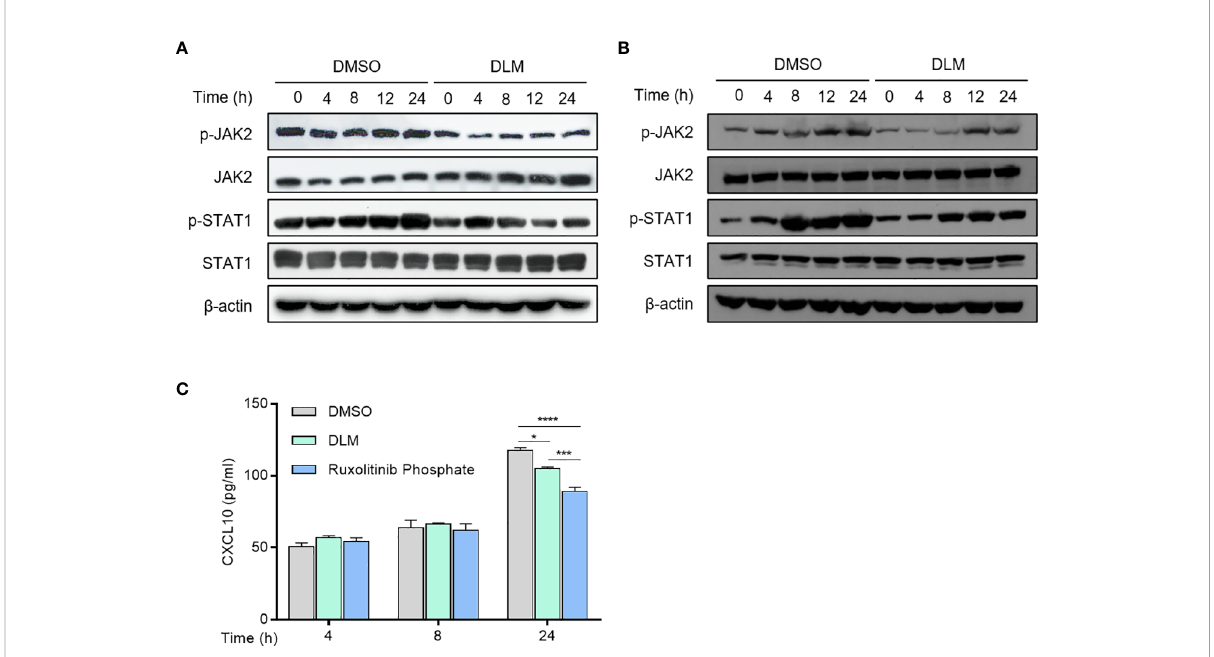
FIGURE 5 Effect of DLM on JAK/STAT1 pathway in macrophages. (A) Macrophages were treated with DLM or DMSO, respectively, for 0-24 h. (B) Macrophages were infected with DLMr-MTB and then incubated for an additional 0-24 h with DLM (0.3 m g/mL). Western blot analysis was performed by using antibodies to p-JAK2, JAK2, p-STAT1 and STAT1, respectively. b -actin was used as control. (C) Macrophages were treated with DLM, DMSO, Ruxolitinib phosphate (1uM), respectively, for 0-24 h. The cell culture supernates were subjected to ELISA analysis to measure CXCL10 protein level. Data are presented as mean ± SEM. *p<.05, ***p<.001, and ****p < .0001 (two-way ANOVA). Results are representatives from at least three independent